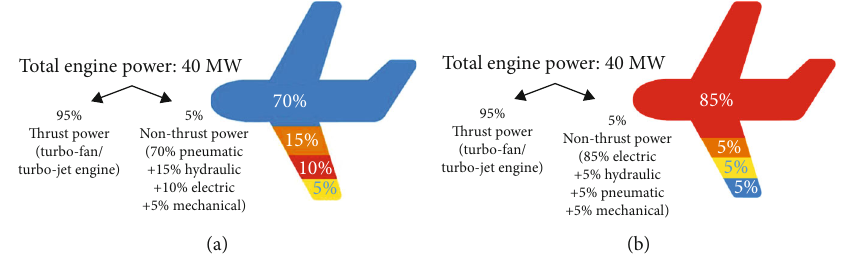
Figure 3: The nonpropulsive powers of (a) CAPC and (b)